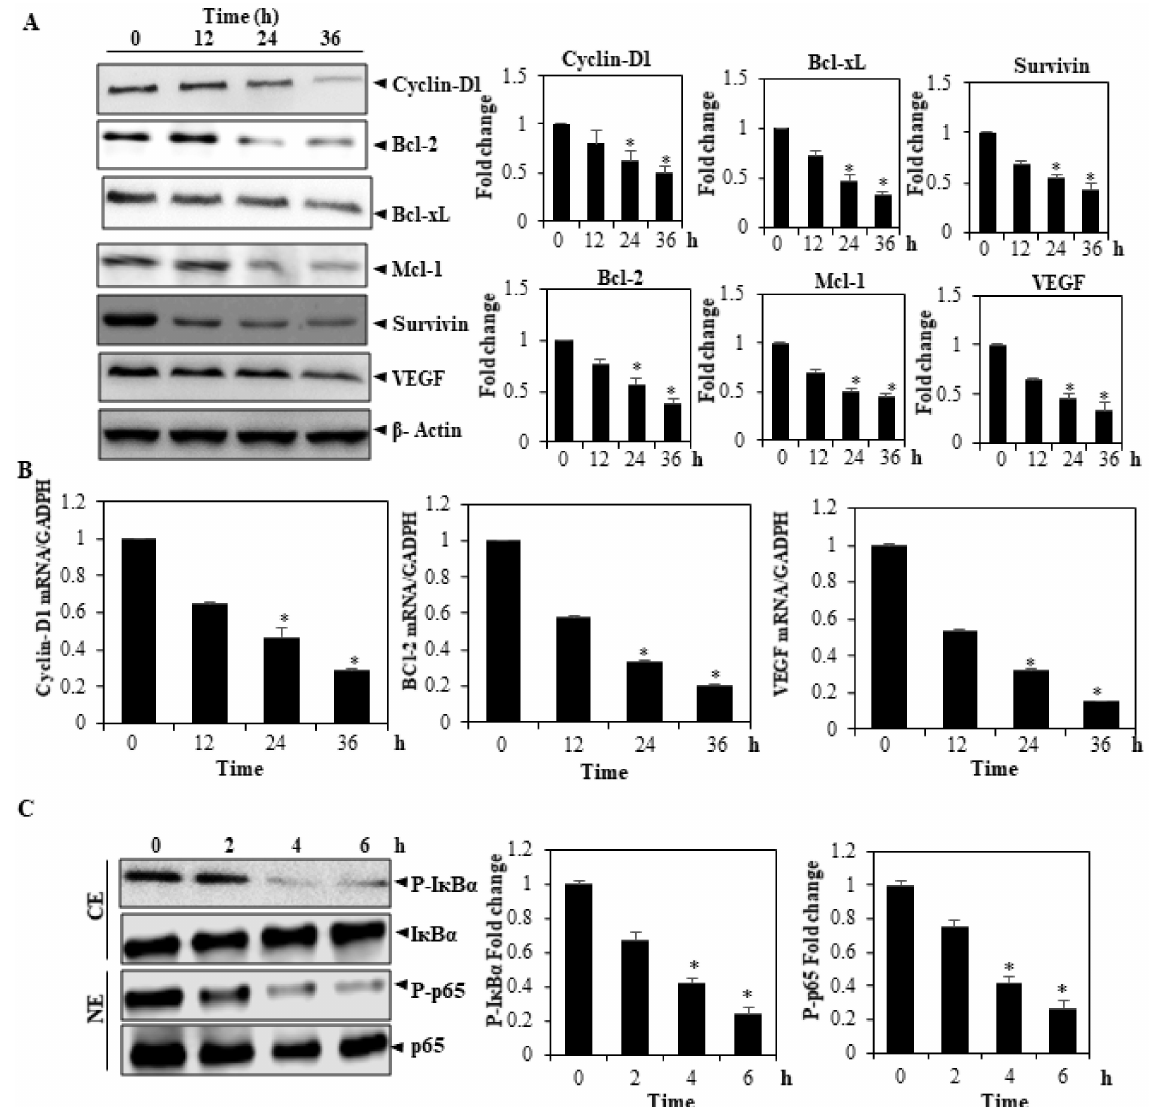
Figure 4. ( A ) can inhibit the production of proteins from genes regulated by STAT3 involved in survival, angiogenesis, and proliferation. After treating HepG2 cells with 15 µ mol/mL of ACN for the indicated amounts of time, extracts of the entire cells were taken, of which 30 mg was resolved over SDS-PAGE gel (10–15%) and transferred to membranes, which were sliced in accordance with molecular weight. They were then investigated using the following antibodies: Mcl-1VEGF, Bcl2, Mcl 1, D1, and Bcl-xl. The β -actin antibody was used to strip/re-investigate these blots for ensuring equal protein loading. ( B ) After treating HepG2 cells with ACN, the cells were harvested following treatment, followed by the extraction of RNA samples. Notably, 1 mg of these RNA extracts was used to conduct reverse transcription for generating the corresponding cDNA. PCR was performed in real time for measuring relative mRNA quantities ( C ). All gene products were characterized using the aforementioned antibodies, with GAPDH being established as an endogenous control for normalization of samples. Sequence Detection Software version 1.3 was used to analyze the results. Following normalization using GAPDH and verifying the threshold cycle difference between untreated and treated cells, we obtained the relative gene expression levels. Cytosolic nuclear fractionation and Western blot analysis of the effects of ACN on Pp65 and p-IkB α levels are also illustrated. The findings signify three experiments carried out independently (* p <